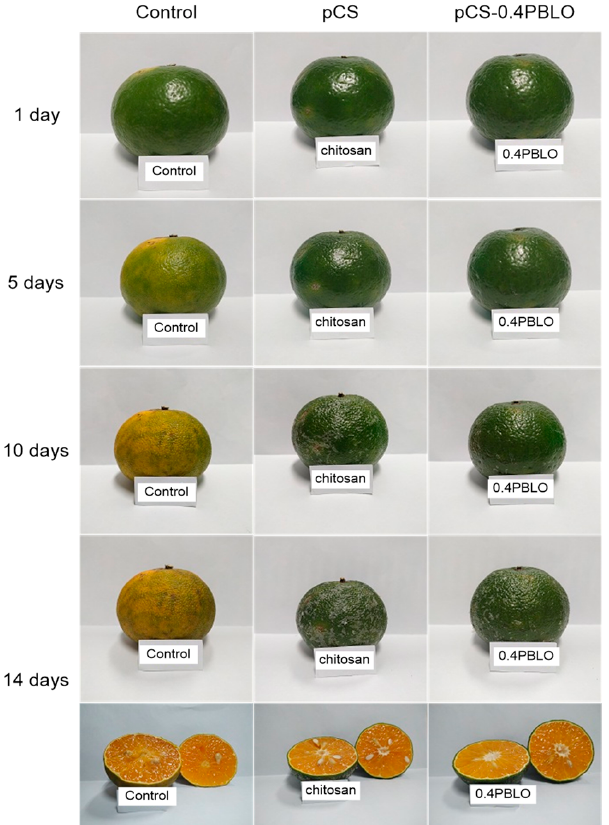
Figure 7. The visual appearance of king oranges with and without coating stored at 25 °C for two weeks.